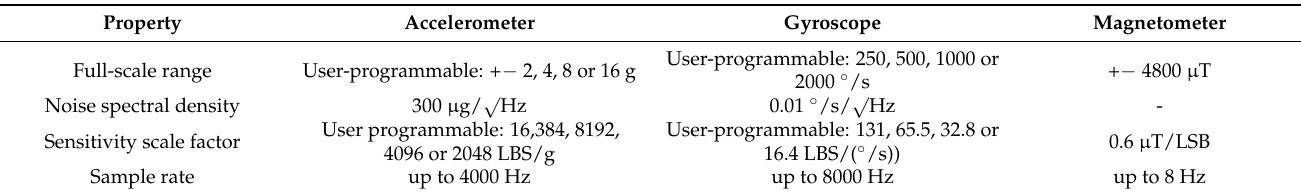
Table 1. MPU-9250 accelerometer, gyroscope, and magnetometer main features